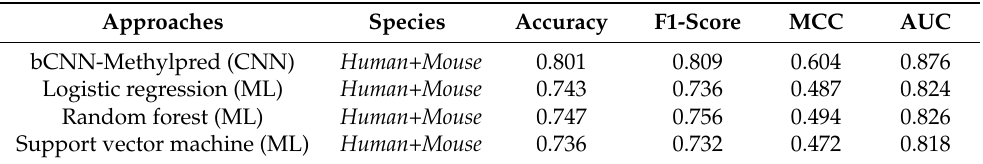
Table 12. Comparison of m6A site prediction using proposed CNN-based approach and state-of-the- art machine learning approaches based on human and mouse species.